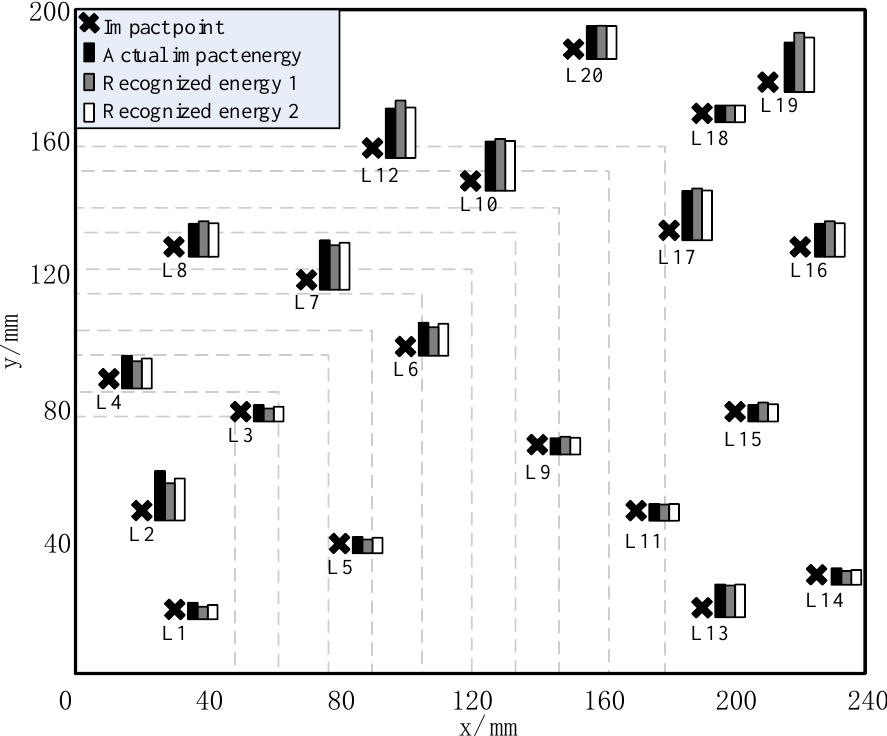
Figure 10. The schematic of the low velocity impact energy verification experimental results on variable thickness composite